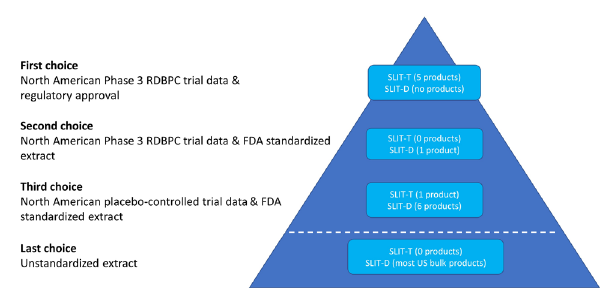
Figure 2. Suggested algorithm for selecting a sublingual immuno- therapy product in North America. There are no SCIT products approved based on Phase 1-3 trials by regulatory agencies in North America. FDA, US Food and Drug Administration; RDBPC, randomized, double-blind,